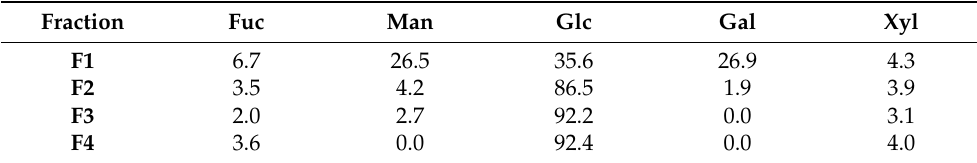
Table 3. Molar ratio (%) of monosaccharides in the fractions obtained from basidiocarps of G. resinaceum .